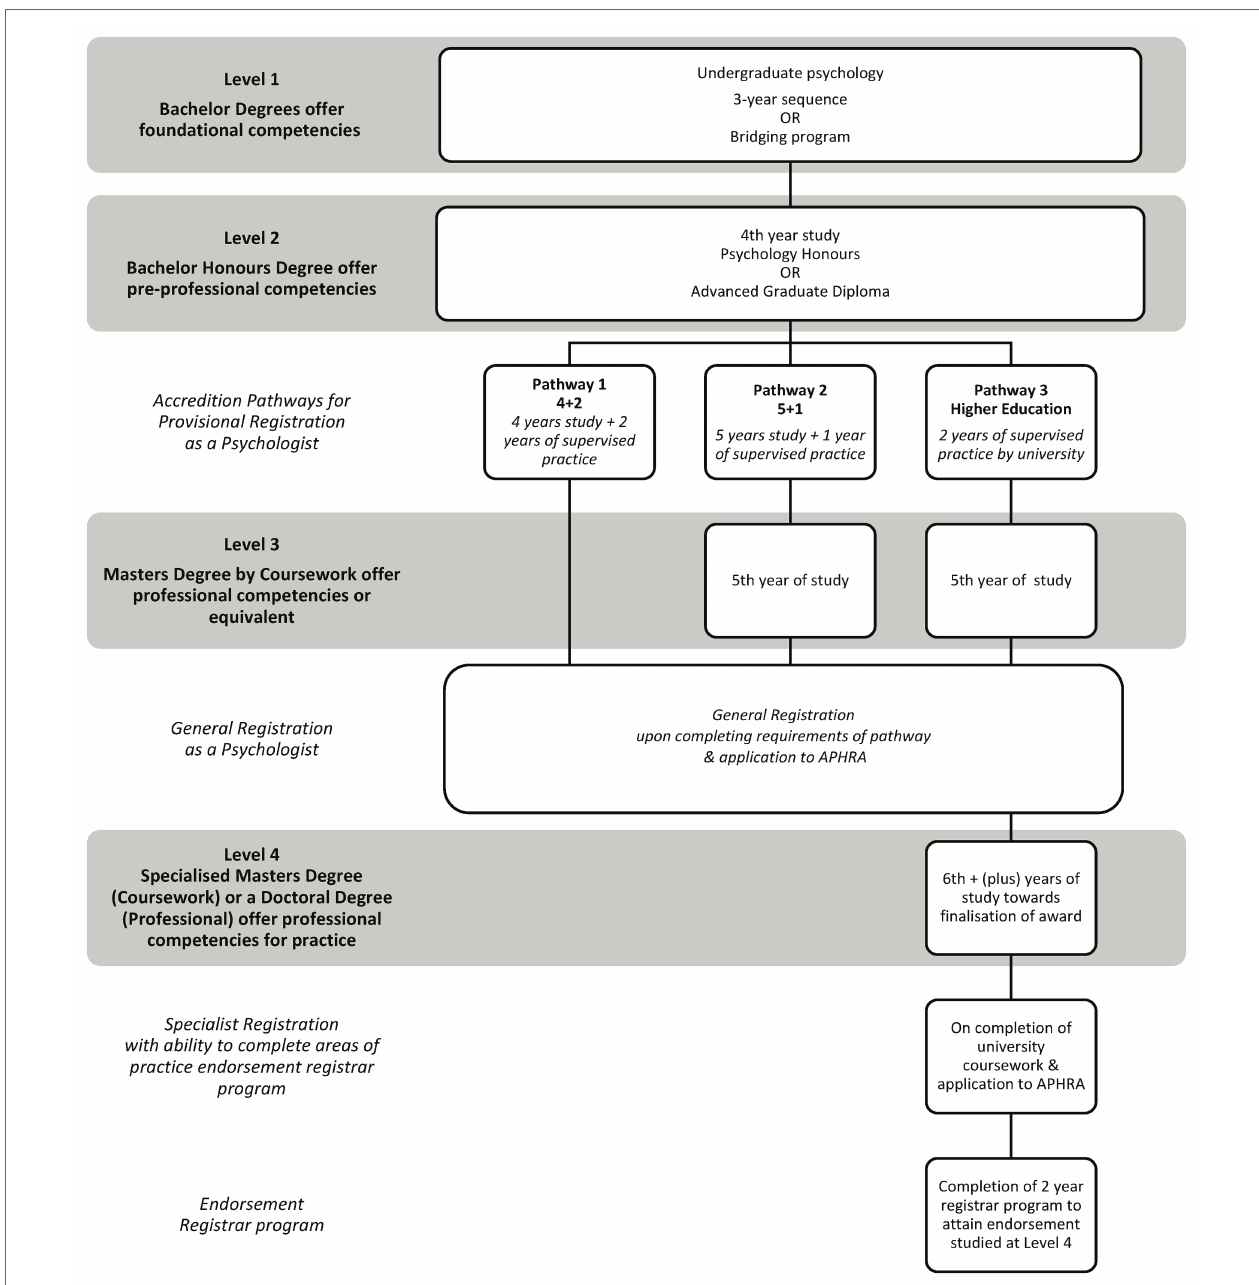
FIGURE 1 | Australian Psychology Accreditation Council (APAC) accreditation pathways for registration as a psychologist in Australia. Adapted from: APAC (2019, 2020). Please note general bridging courses are being developed and approved for release as of July 2019 for Pathway 1 and 2. Pathway 1 will be retired as of